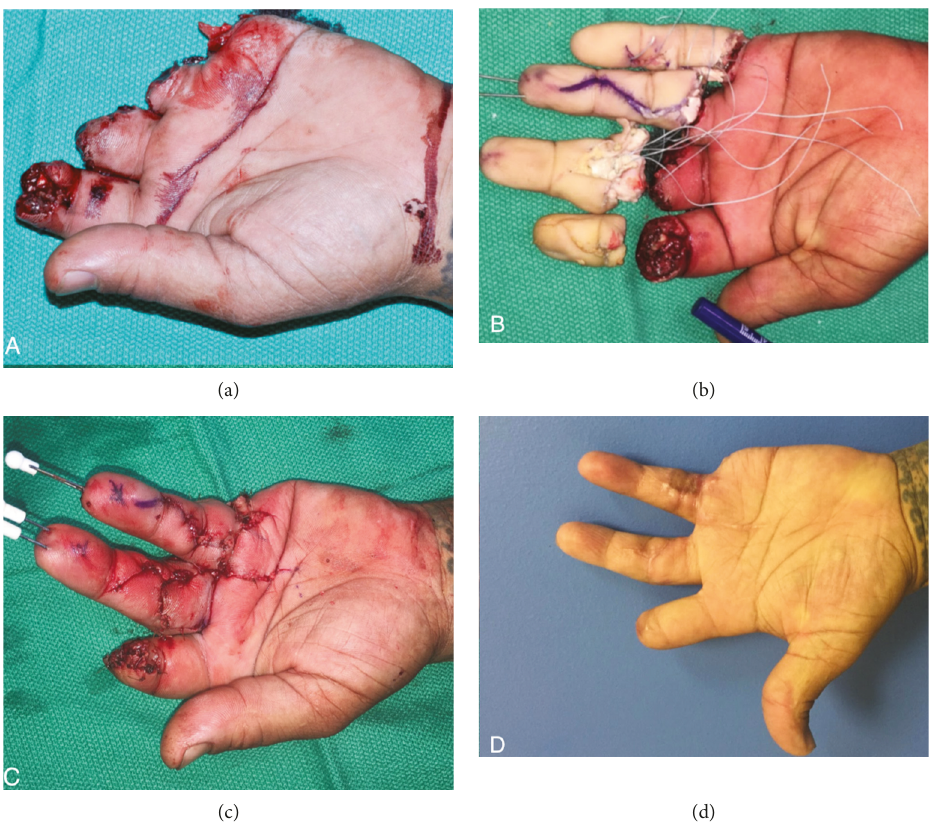
Figure 3: Multiple digit replantation. Panel (a) shows the initial injury, and panel (b) shows the digit parts for attempted replantation with tendons tagged. The index fi nger was amputated too distal to allow replantation, and the small fi nger part was too mangled to allow microsurgical anastomosis; revision amputation was employed in these fi ngers. The immediate postoperative photo is seen in panel (c). Final healed result is seen in panel